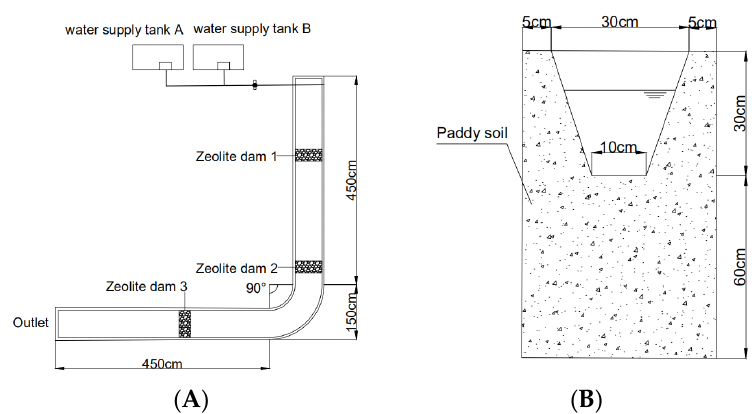
Figure 2. Top view of eco-ditch model design ( A ); front view of eco-ditch model design ( B ).